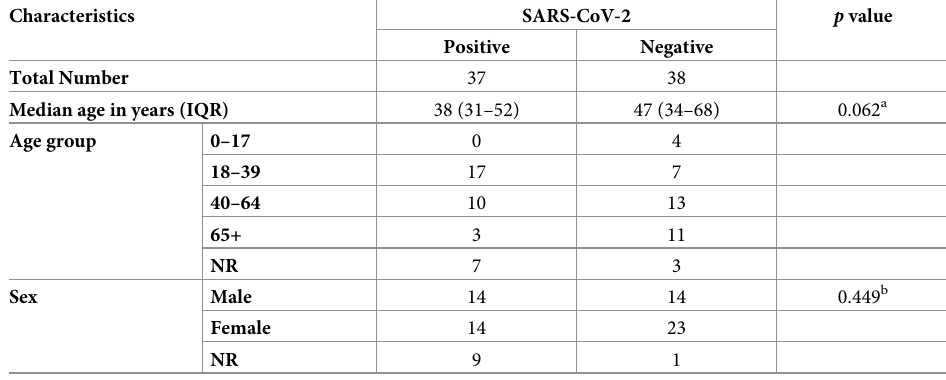
NR: Data not recorded; IQR: inter-quartile range; a Mann-Whitney U test; b Fisher’s exact